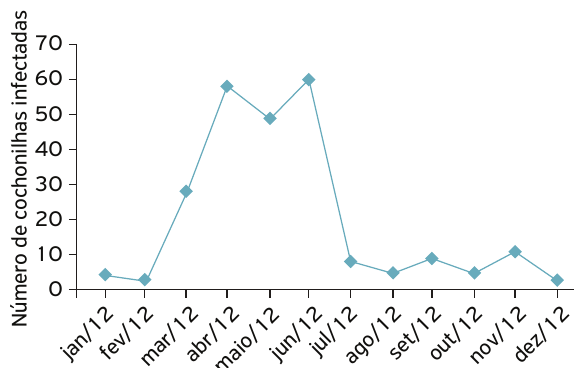
Figura 1. Número de cochonilhas infectadas, no período de janeiro a dezembro de 2012, na cultura da mandioca da variedade fécula branca, em Porto Mendes, Marechal Cândido Rondon,